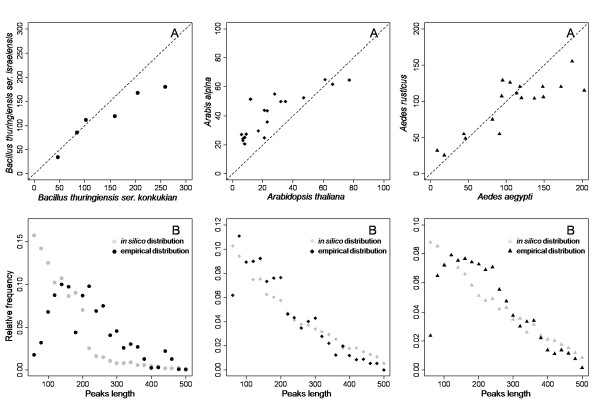
In silico AFLPs obtained on model species vs. empirical AFLPs obtained on related non-model species. A) Comparison between numbers of peaks per profile obtained for model and non-model species. B) AFLP peak length distribution obtained in silico and empirically. Peaks were grouped by classes of 20 bp-length. Symbols ● corresponded to bacteria species, ◆ to plant species and ▲ to insect species.